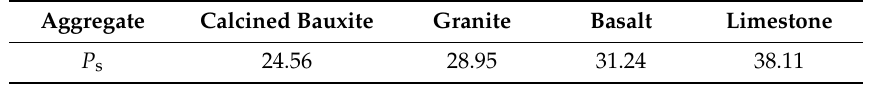
Table 10. Calculated maximum macrotexture polished values P s for the di ff erent aggregate